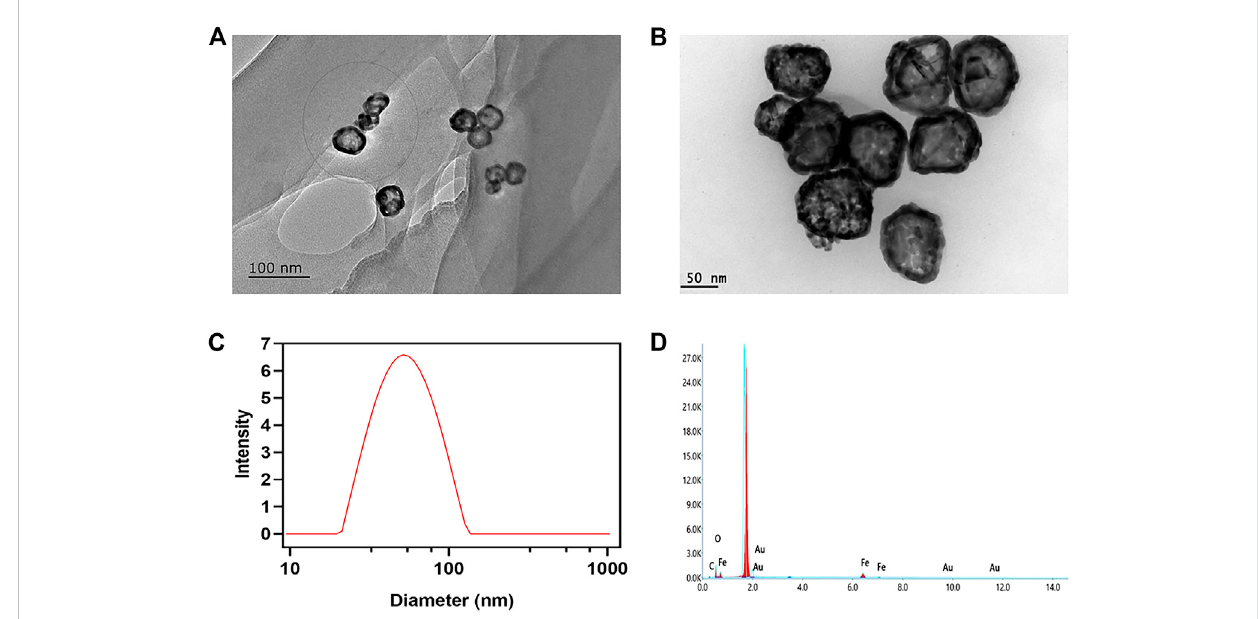
FIGURE 1 Characterization of AuNC@Fe 3 O 4. (A) Transmission electron microscope (TEM) images of AuNC. Scale bar: 100 nm. (B) TEM images of AuNC@ Fe 3 O 4 . Scale bar: 50 nm. (C) Dynamic light scattering (DLS) result of AuNC@Fe 3 O 4 . (D) Energy-dispersive X-ray (EDX) result of AuNC@Fe 3 O 4 .